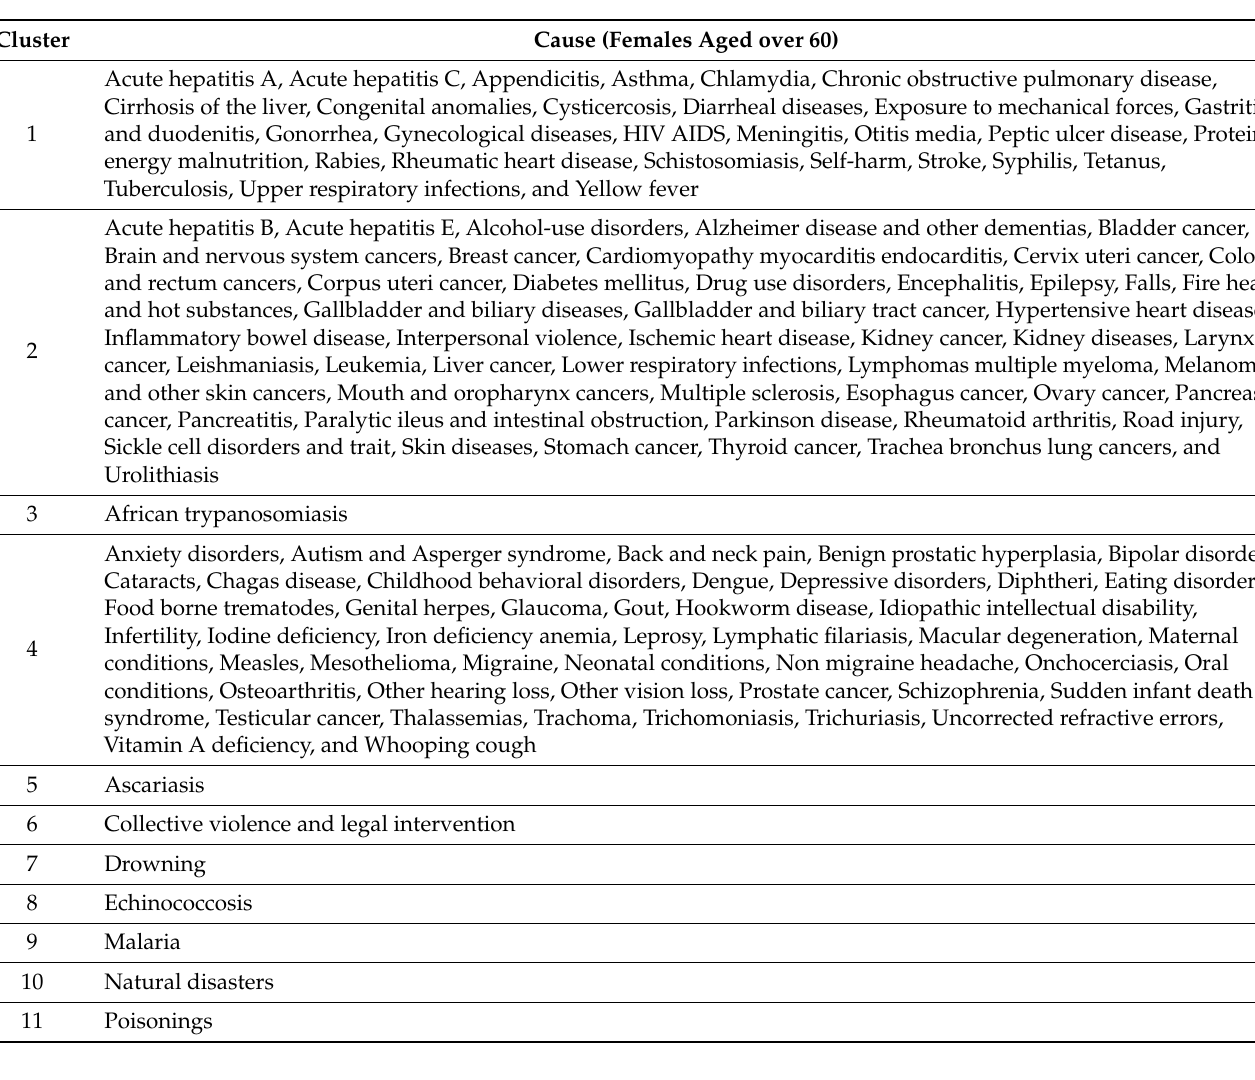
Table A4. Cluster members for females aged over 60.